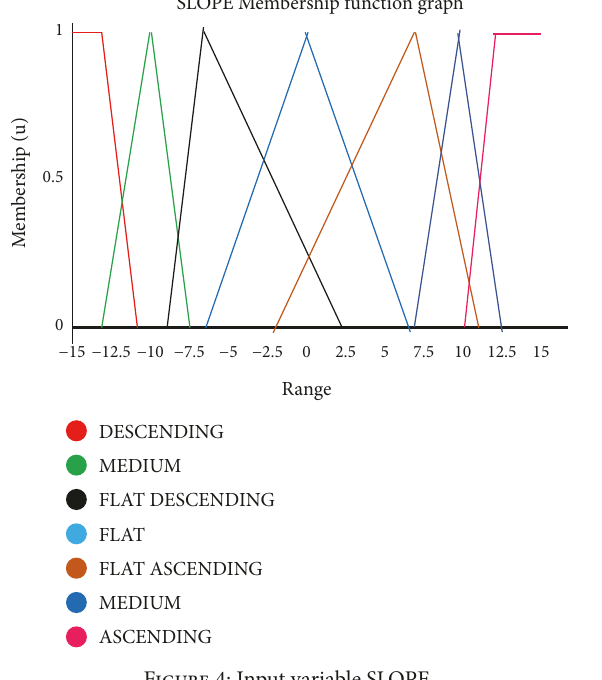
Figure 4: Input variable SLOPE.